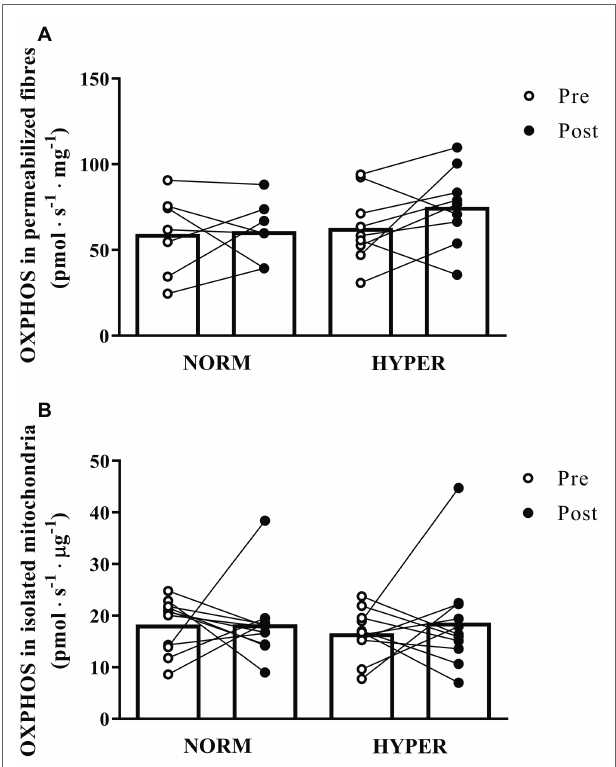
FIGURE 3 | Maximal mitochondrial respiration (OXPHOS) pre and post 6 weeks polarized and periodized high-intensity interval training either in normoxia (NORM) or hyperoxic-supplemented (HYPER). All values are shown as mean and individual response following the intervention. In panel (A) , O 2 flux rates obtained from measurement of mitochondrial respiration using permeabilized fibers technique are expressed in pmol s −1 mg −1 fibers initial wet weight, whereas in panel (B) , O 2 flux obtained from measurement of isolated mitochondria are presented in pmol s −1 μg −1